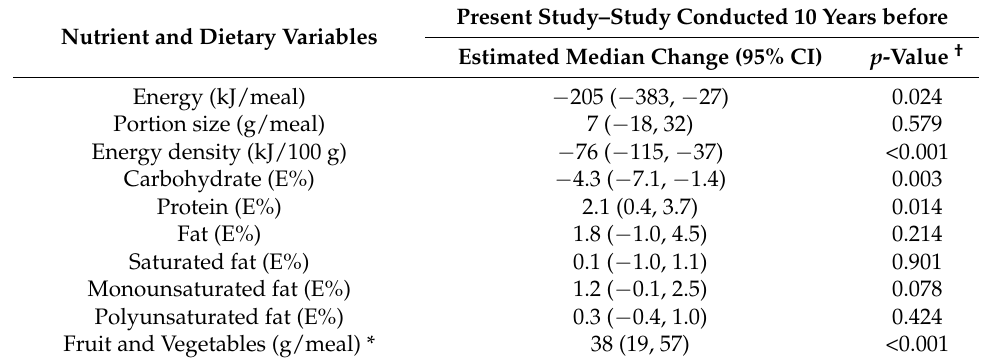
Table 5. Estimated median change from the study 10 years before and present (estimated using linear mixed models adjusted for sex, age, BMI and education). Present Study–Study Conducted 10 Years Nutrient and Dietary Variables